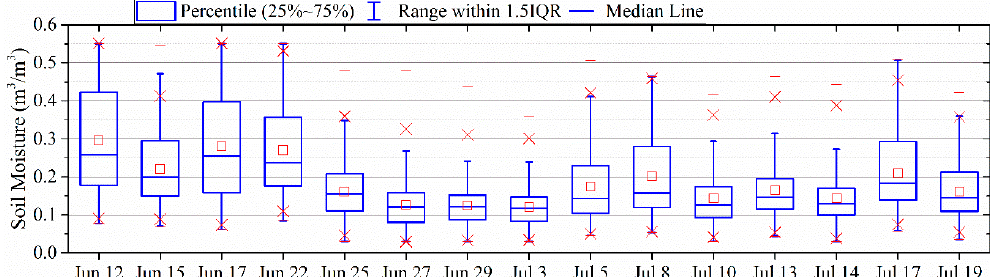
Figure 6. Box chart of the PALS soil moisture (m 3 /m 3 ) during the SMAPVEX12 experiment.